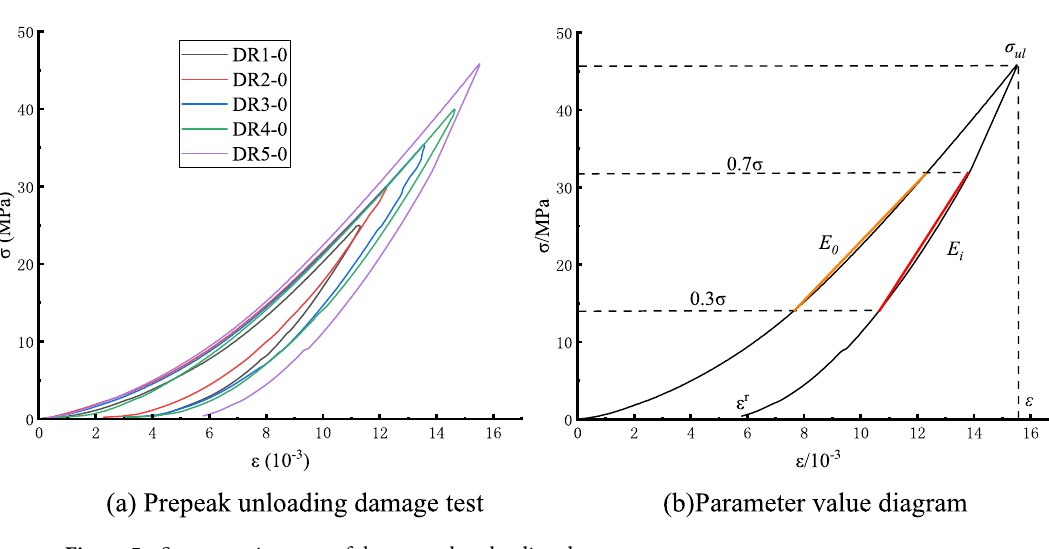
Figure 5. Stress–strain curve of the prepeak unloading